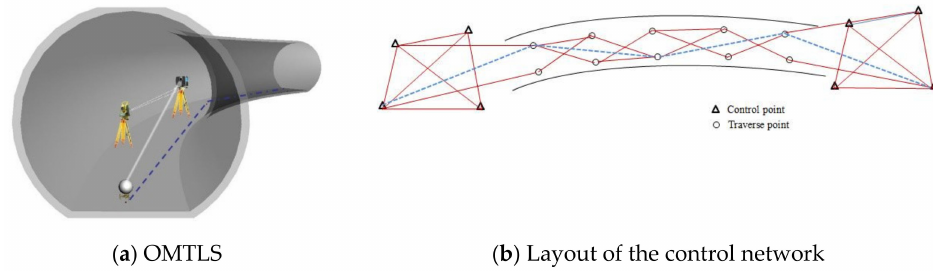
Figure 10. Implementation of